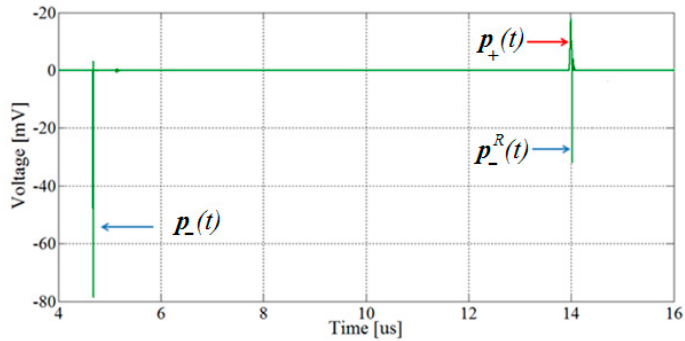
Figure 6. Simulation result for dielectric thickness equal to 20 mm and ground electrode thickness equal to 30 mm. The positive acoustic wave overlaps with the negative wave reflected within the ground electrode.